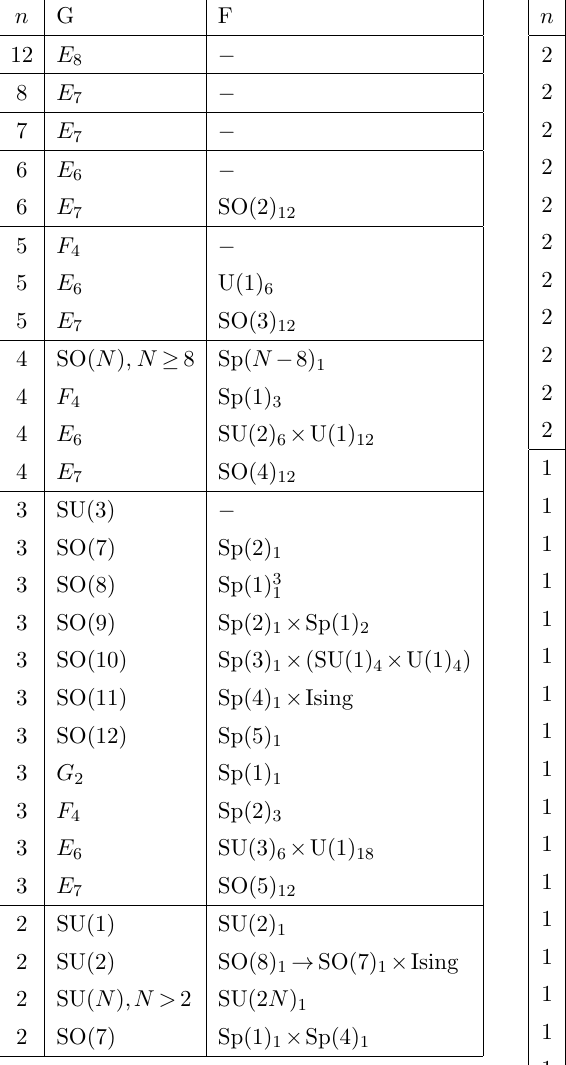
6d SCFTs. The ??? G = (cid:0) n is G